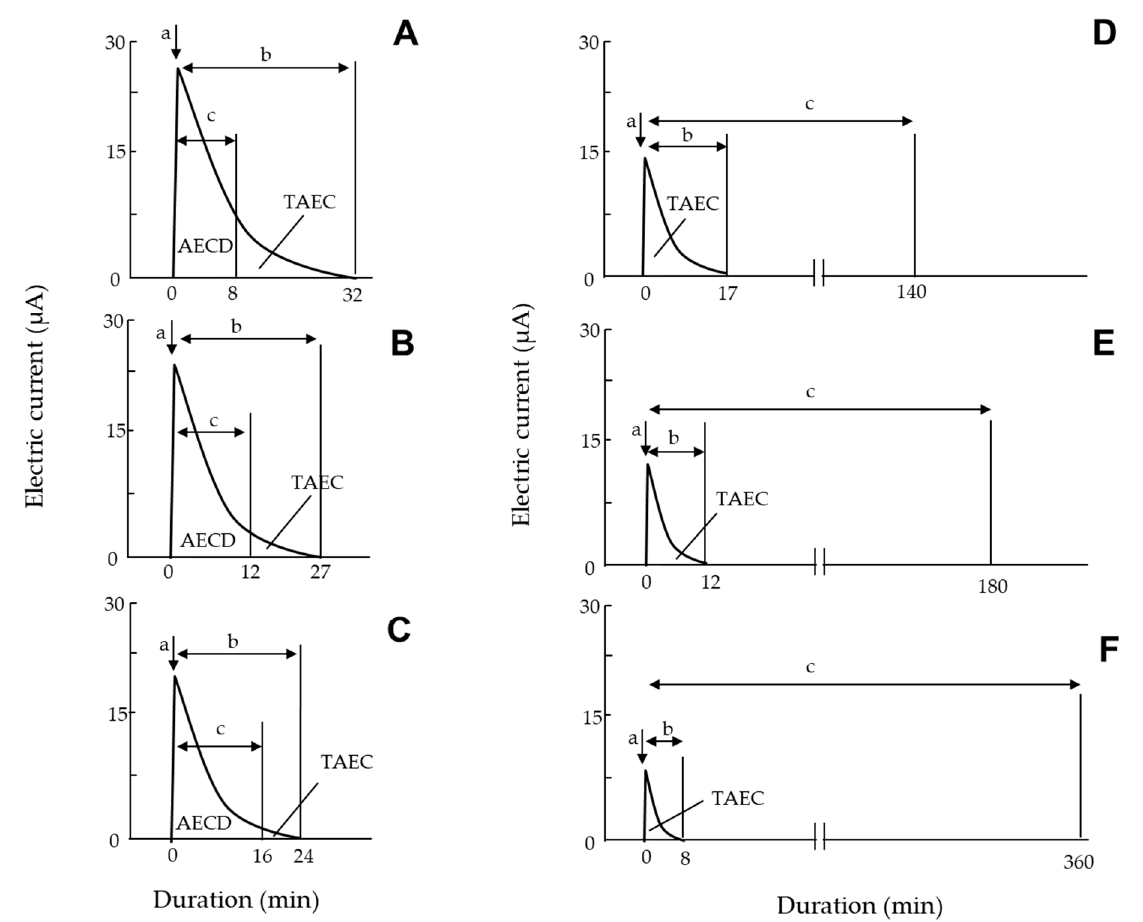
Figure 7. Typical profiles of electric current generated by an adult housefly placed on the GIP of an EFP negatively charged with ( A ) − 15, ( B ) − 14.5, ( C ) − 14, ( D ) − 12, ( E ) − 10, and ( F ) − 8 kV. Arrows a and b indicate the electric current produced by the fly upon attraction to the N-PIP and the subsequent electric current generated by the captured fly, respectively. The total amount of electricity released from the captured fly was determined as the total amount of electric current (TAEC; µA min) generated by the fly, and calculated as the area bounded by the x-axis and the profile curve of current generation. Arrow c indicates the time until death of the captured fly. The total amount of electric current (AECD) until fly death was also calculated.